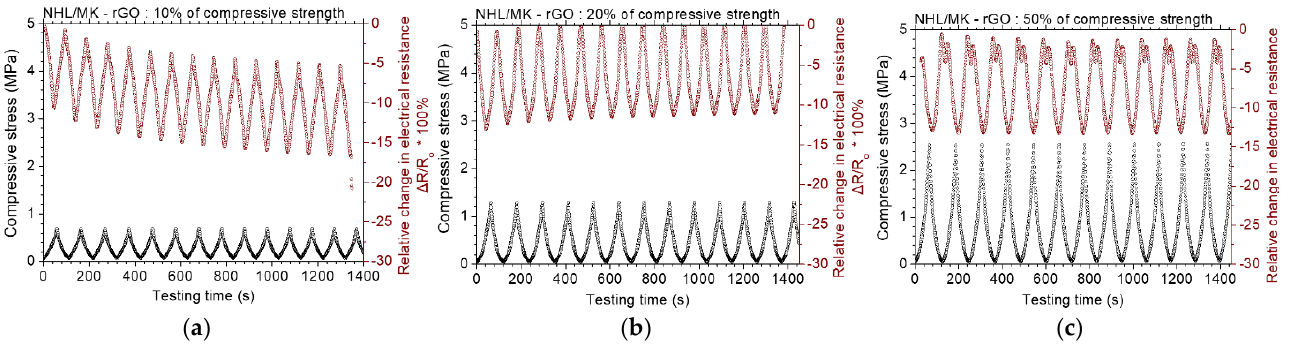
Figure 11. Cyclic, piezoresistive response of rGO reinforced binary paste at constant amplitude level of ( a ) 10%, ( b ) 20% and ( c ) 50% of the compressive strength of the paste.